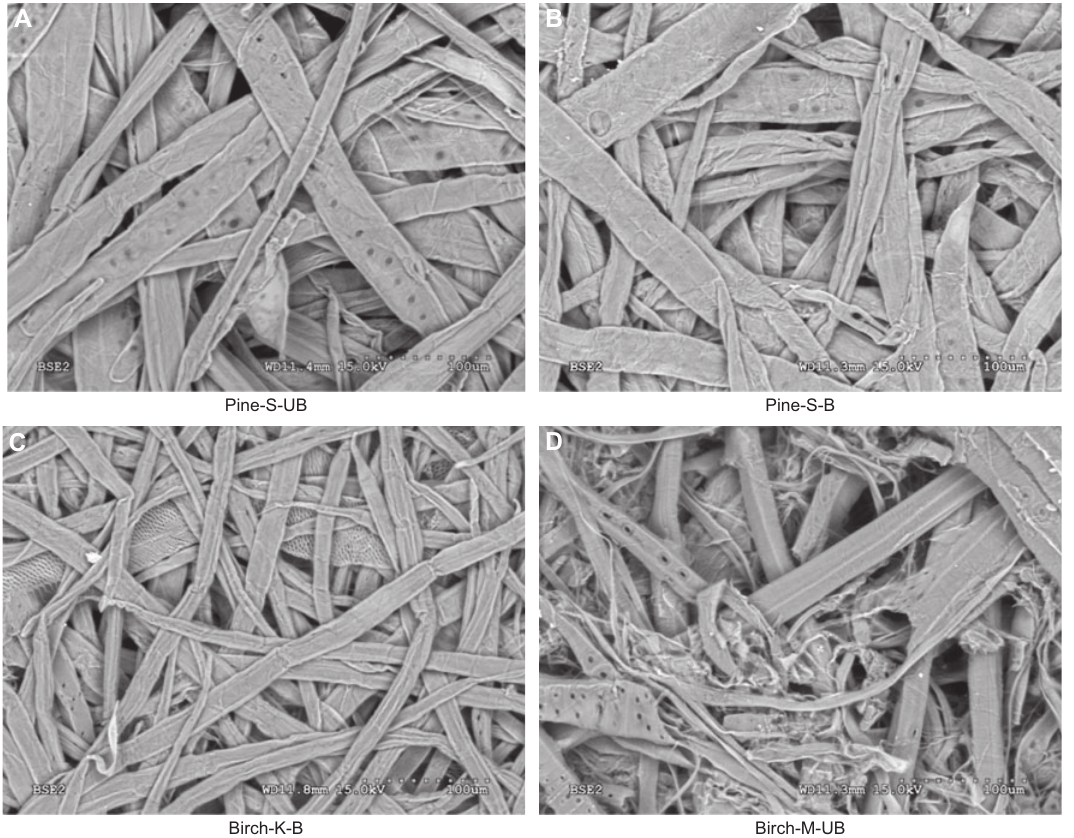
Figure 1 Scanning electron images of handsheets made from unbeaten different wood fibers.